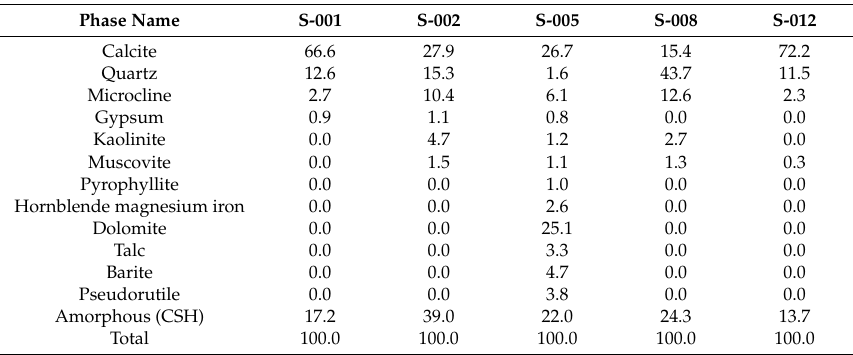
Table 2. Mineralogical composition